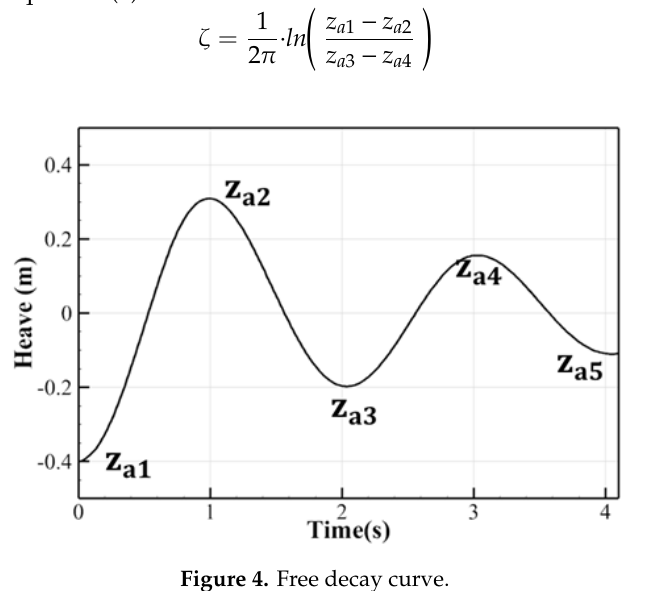
Figure 4. Free decay curve.